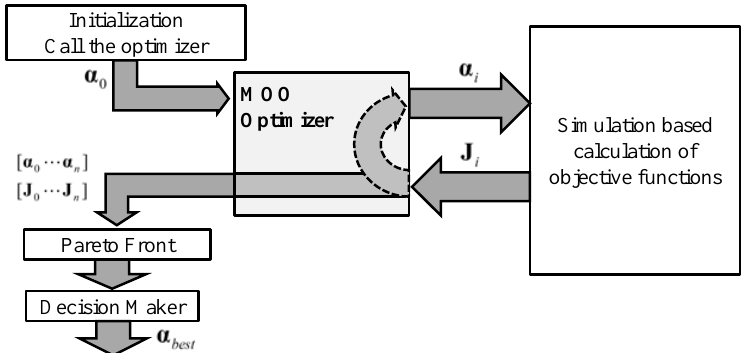
Figure 3. Scheme for optimization process with simulation-based evaluation of objective functions.